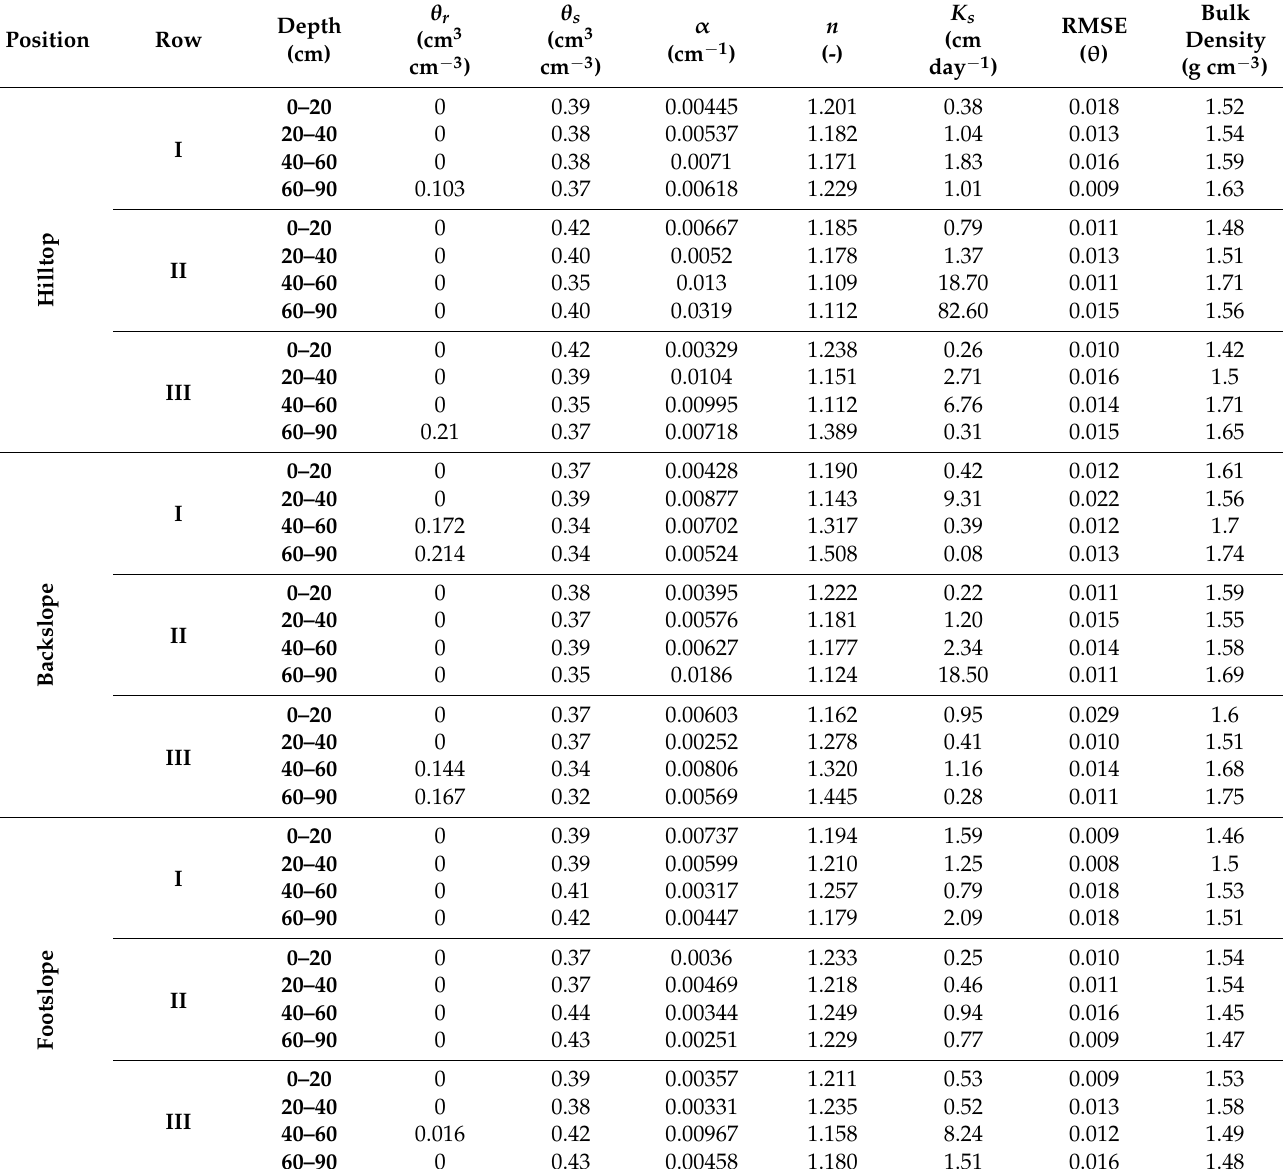
Table 2. van Genuchten-Mualem (VGM) hydraulic properties evaluated by HYPROP-FIT for the hilltop, backslope, and footslope for four depths (0–20, 20–40, 40–60, and 60–90 cm) and three vineyard rows at the SUPREHILL